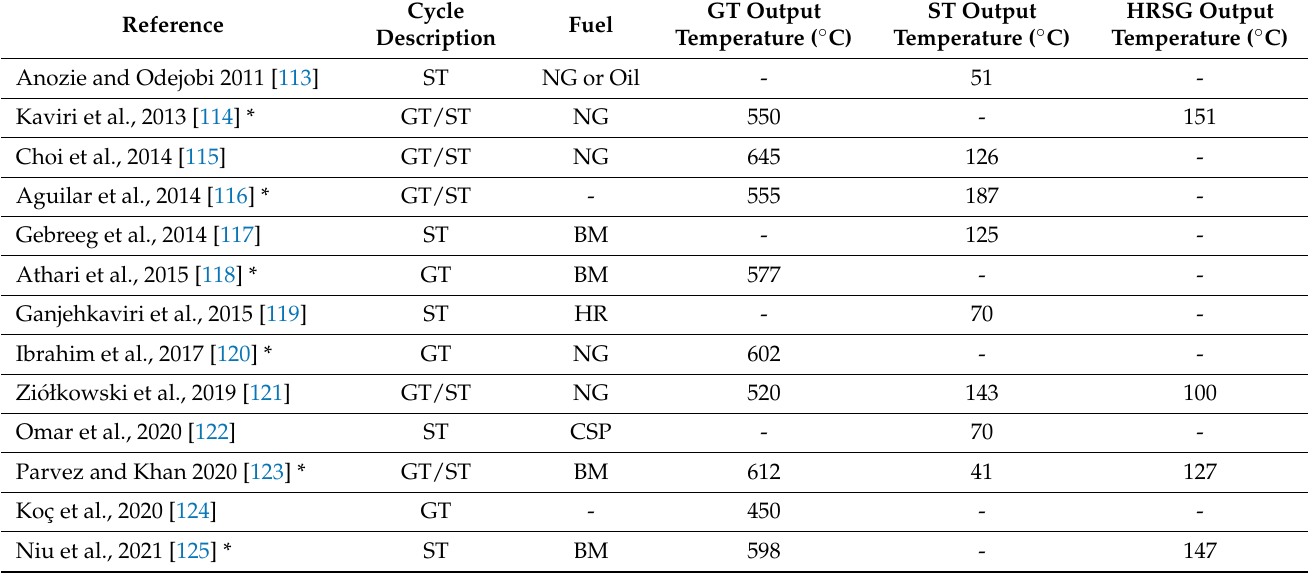
Table 10. Literature review of the values for gas and steam turbine selected parameters.